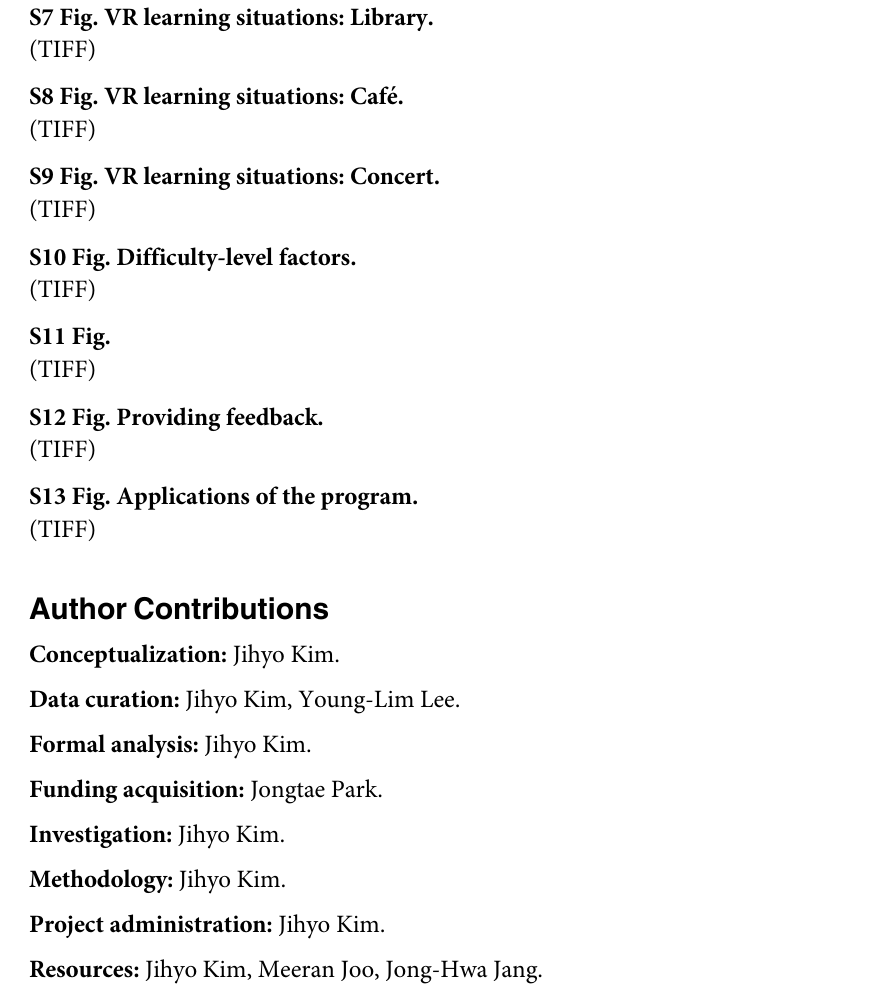
S7 Fig. VR learning situations: Library. (TIFF) S8 Fig. VR learning situations: Cafe´. (TIFF) S9 Fig. VR learning situations: Concert. (TIFF) S10 Fig. Difficulty-level factors. (TIFF) S11 Fig. (TIFF) S12 Fig. Providing feedback. (TIFF) S13 Fig. Applications of the program.